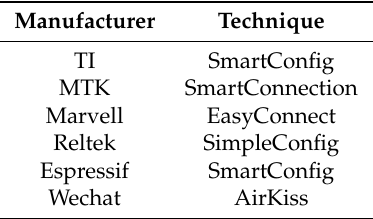
Table 1. Solutions of